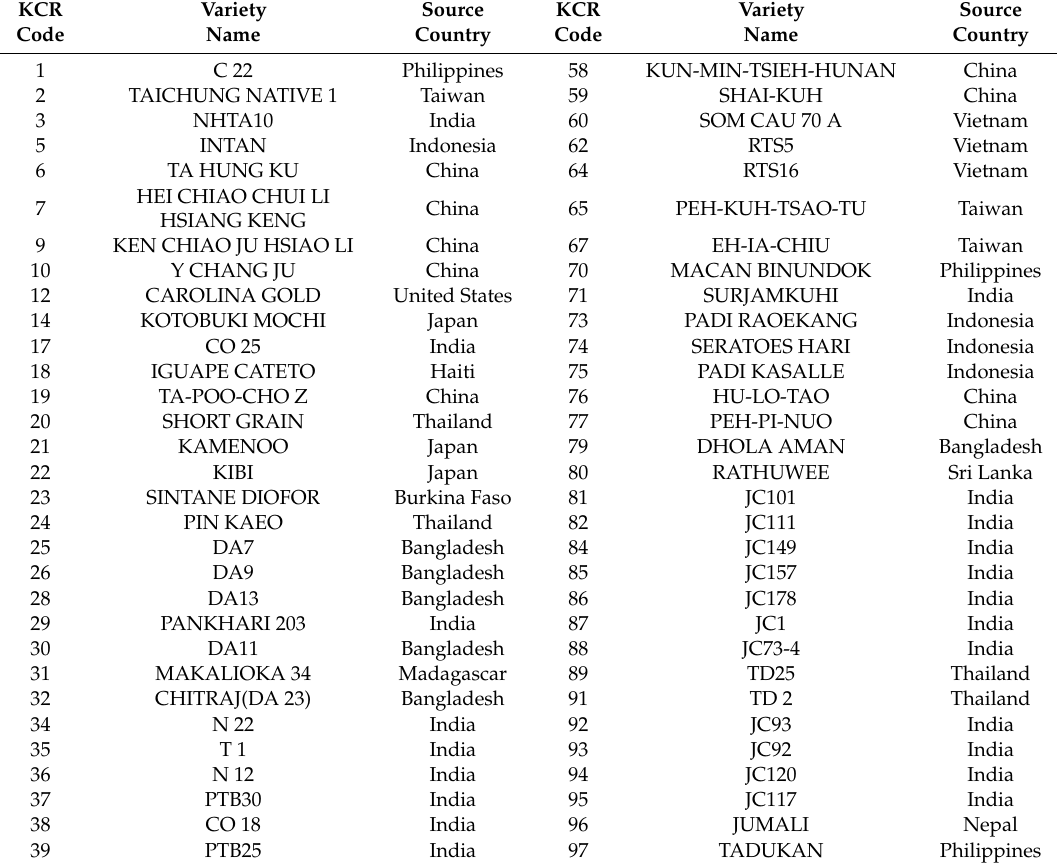
Table 1. Rice varieties used in this